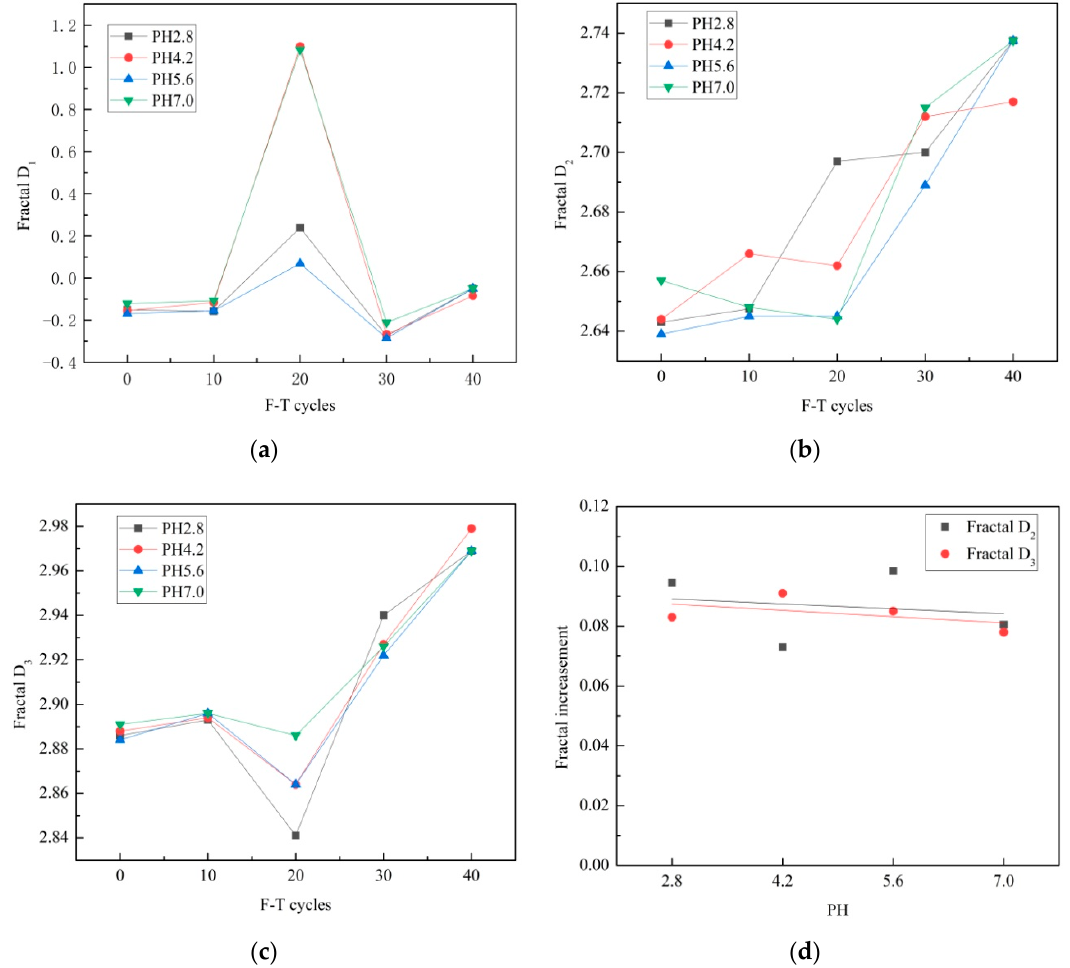
Figure 6. Segmented fractal dimensions of sandstone immersed in acid solutions after different F–T cycles: ( a ) micro-pore dimension D 1 ; ( b ) meso-pore dimension D 2 ; ( c ) macro-pore dimension D 3 ; ( d ) D 2 and D 3 of samples in different acidic solutions under 40 F–T cycles.